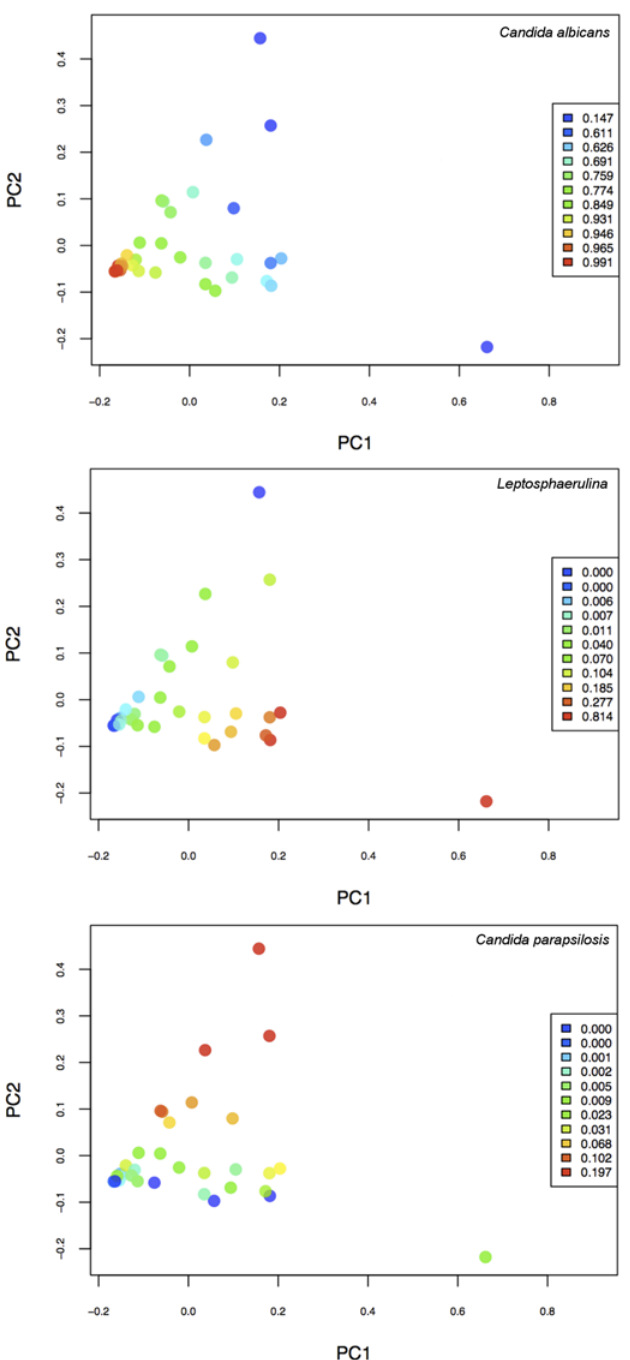
Fig 4. Principal Coordinates analysis of dominant taxa in infant fecal samples. Principal coordinates analysis of Bray-Curtis dissimilarities among the three most abundant taxa ( C . albicans , Leptosphaerulina , and C . parapsilosis ) was performed for each sample. Each sample is represented by a dot and is colored based on the abundance (indicated in the legend) of the taxon indicated in the title of the graph. The C . albicans - Leptosphaerulina tradeoff is driving the first (PC1) axis (from bottom to top), and the C . albicans - C . parapsilosis tradeoff is driving the second (PC2) axis (from left to right), in all graphs.